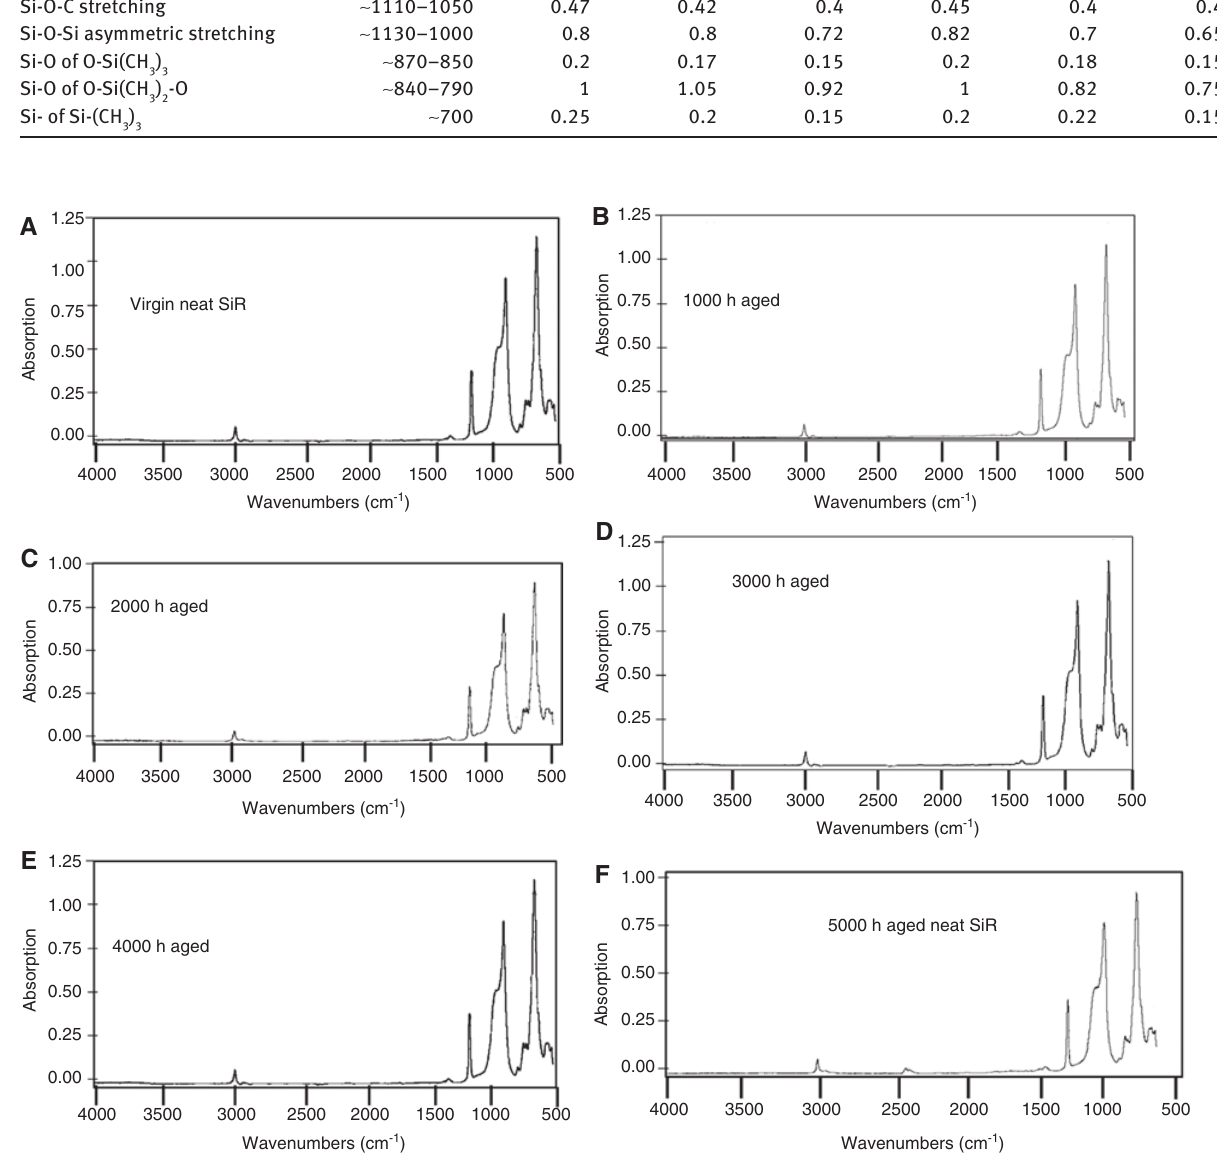
Figure 8: FTIR spectrographs of neat SiR: (A) virgin, (B) 1000 h aged, (C) 2000 h aged, (D) 3000 h aged, (E) 4000 h aged, and (F) 5000 h